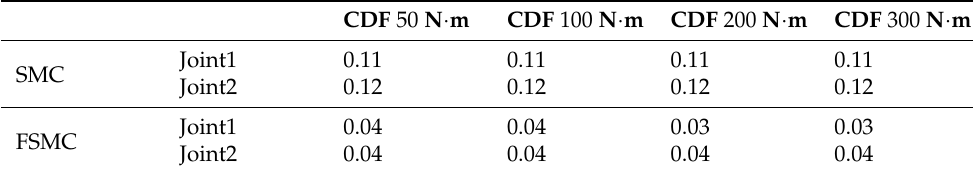
Figure 4. Position tracking error curves of double-joint under different CDF. ( a ) Tracking error of joint1 with 50 N · m CDF. ( b ) Tracking error of joint2 with 50 N · m CDF. ( c ) Tracking error of joint1 with 100 N · m CDF. ( d ) Tracking error of joint2 with 100 N · m CDF. ( e ) Tracking error of joint1 with 200 N · m CDF. ( f ) Tracking error of joint2 with 200 N · m CDF. ( g ) Tracking error of joint1 with 300 N · m CDF. ( h ) Tracking error of joint2 with 300 N · m CDF. Table 2. Comparison table of maximum time (s) of dynamic error in different